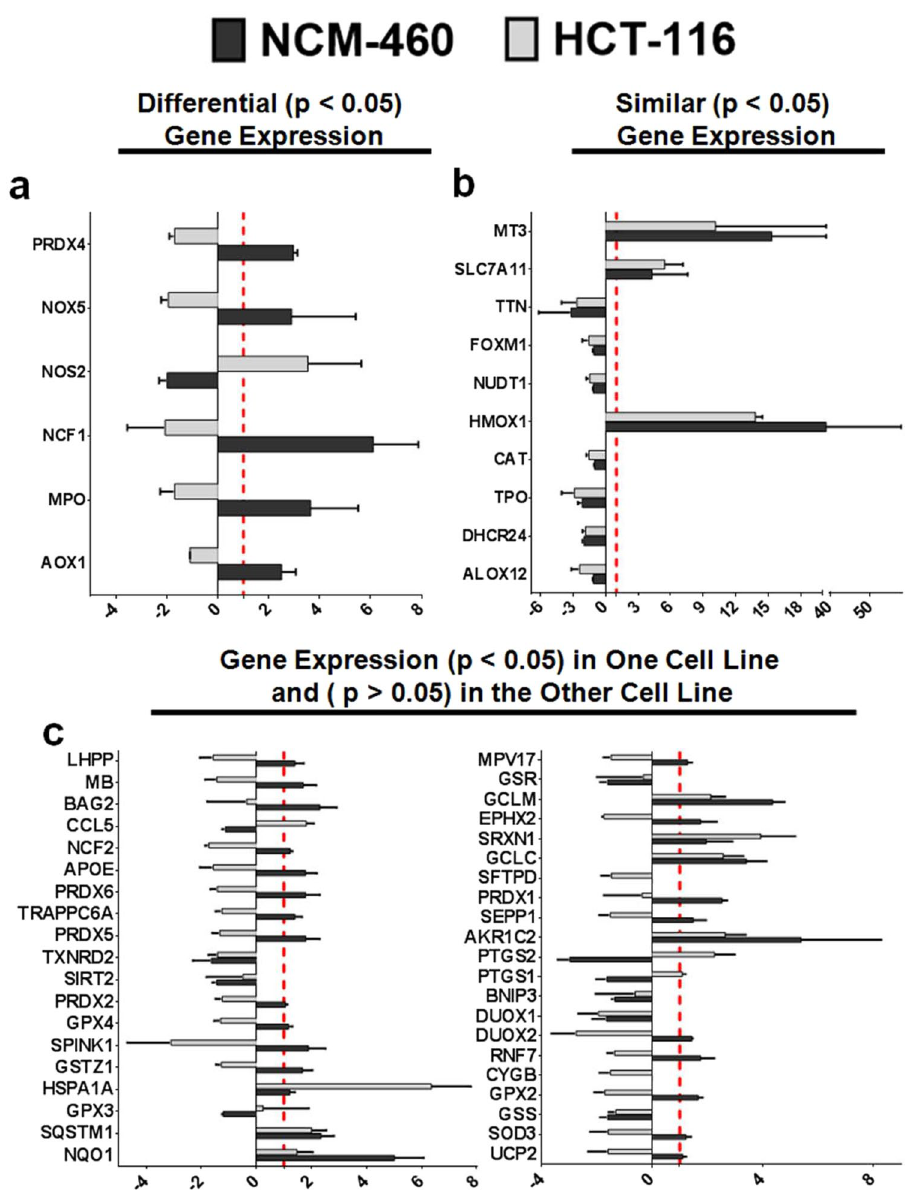
Figure 7. Comparative Change in Oxidative Stress-Related Gene Expression Between Cancerous and Non- Cancerous Cell Lines. The cancerous cell line (HCT-116) and non-cancerous cell line (NCM-460) were treated with the vehicle control (DMSO) or 1 µ M Compound A for 6 hours. RNA isolation and subsequent RT 2 PCR analysis was carried out. Results are shown as a fold-change relative to control following treatment with Compound A of three independent trials. Y-axis: Gene. X-axis: Fold-Change to control. The red dashed line is set at a relative fold-change of one, representing the